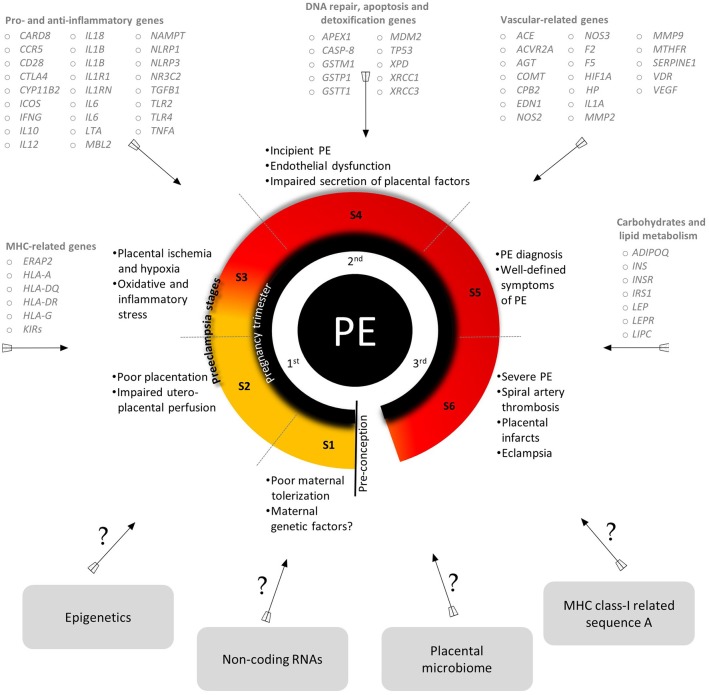
An integrated view of the genes evaluated by Latin American research groups, a summary of key events of PE stages and areas of future investigation in PE. S, stages. Genes are listed according to their approved gene symbol by the HUGO gene nomenclature committee. Detailed information about PE stages are found in Redman et al. (2014). All the genes mentioned and their SNPs are addressed in detail in Tables 1–5.